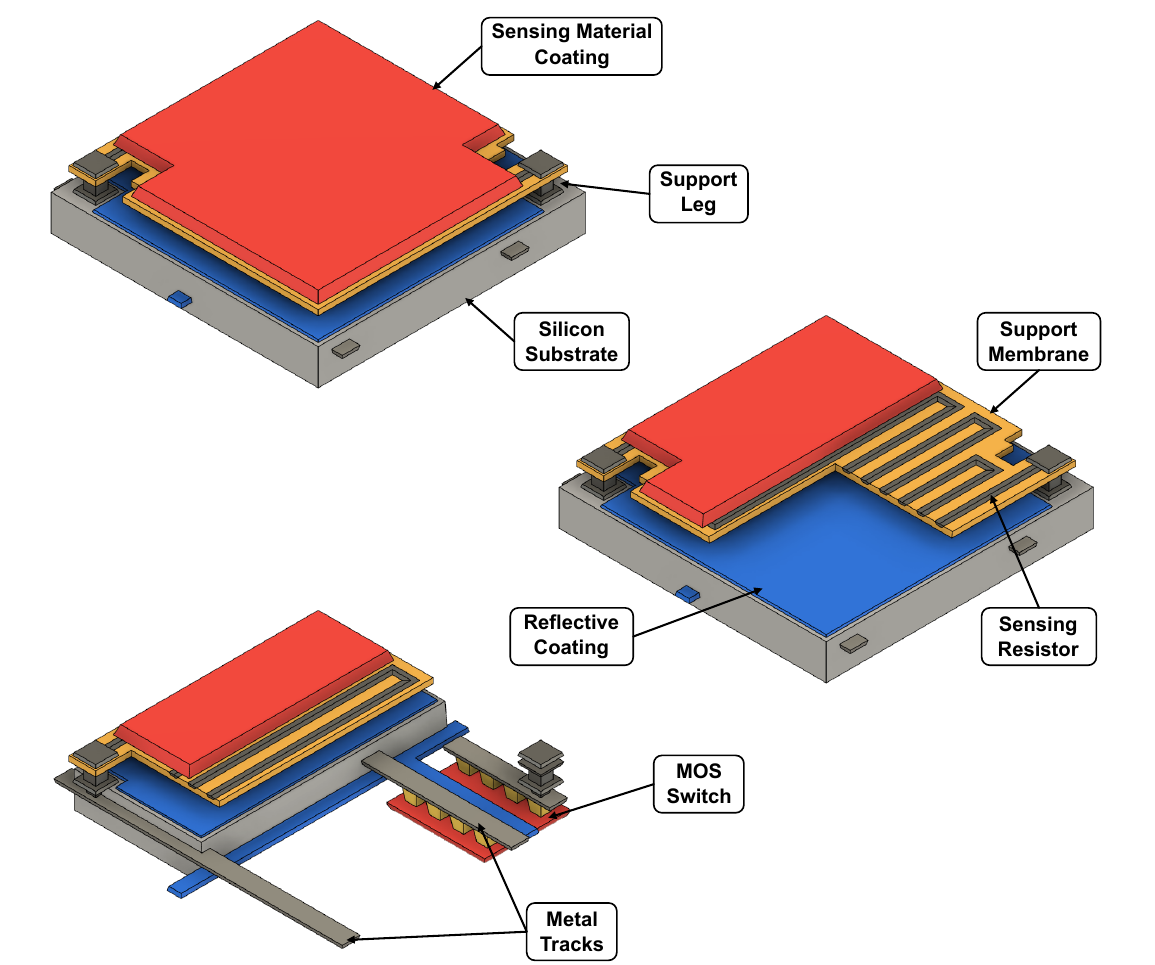
Figure 2. Three-dimensional layout of a micro-bolometer with a breakdown of its main parts.